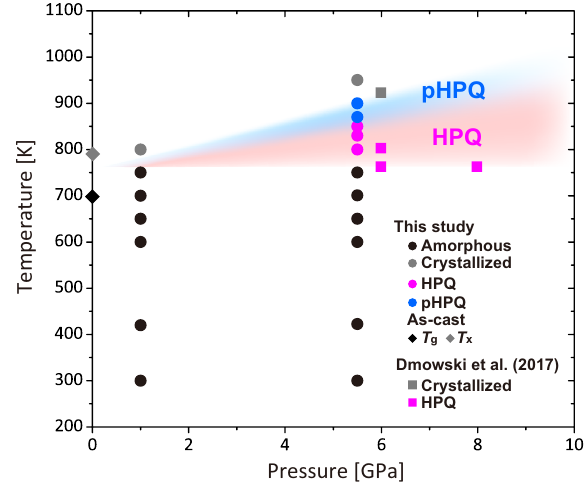
Fig. 1 Experimental pressure and temperature conditions and the sample states identi fi ed by synchrotron X-ray diffraction technique. Black and gray symbols denote the amorphous and crystallized samples, respectively. Purple and blue circles denote the high-pressure quenched (HPQ) and post HPQ (pHPQ) states, respectively (see text). Black and gray diamonds denote the glass transition ( T g ) and crystallization temperatures ( T x ) of the as-cast Zr 50 Cu 40 Al 10 BMG, respectively, measured by a differential scanning calorimetry. Purple and gray squares denote the pressure and temperature conditions where the HPQ and crystallized samples of the Zr 50 Cu 40 Al 10 BMG were reported by Dmowski et al. 14 . Red and blue shaded areas indicate the expected ranges of the HPQ and pHPQ states in the Zr 50 Cu 40 Al 10 BMG,